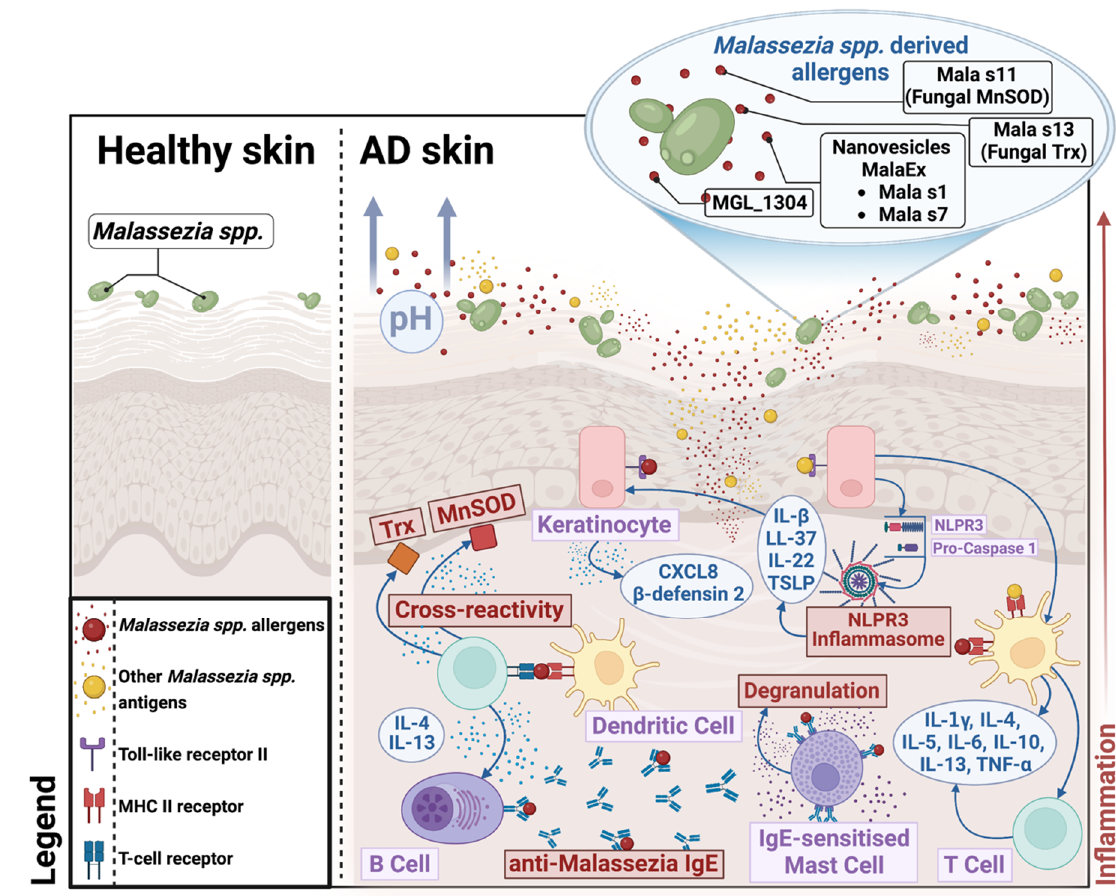
Figure 2. Proposed pathways of Malassezia spp. pathogenicity in atopic dermatitis. The skin of patients with atopic dermatitis is characterized by epidermal barrier damage, increased skin pH, and reduced lipid content, which facilitates the penetration of allergens and other antigens of Malassezia spp. These are recognized by antigen-presenting cells, such as keratinocytes and dendritic cells, inducing the activation of innate and acquired immune responses. This results in the upregulation of antimicrobial peptides; secretion of Th1, Th2, and Th17 cytokines; and production of specific IgE. Cross-reactivity of Malassezia allergens with human thioredoxin and manganese- dependent superoxide dismutase, as well as degranulation of specific IgE-sensitized mast cells, further contribute to the robust cutaneous inflammation. CXCL8—CXC motif chemokine ligand 8; MHC II receptor—major histocompatibility class II receptor; MnSOD—manganese-dependent superoxide dismutase; Trx—thioredoxin; TSLP—thymic stromal lymphopoietin.